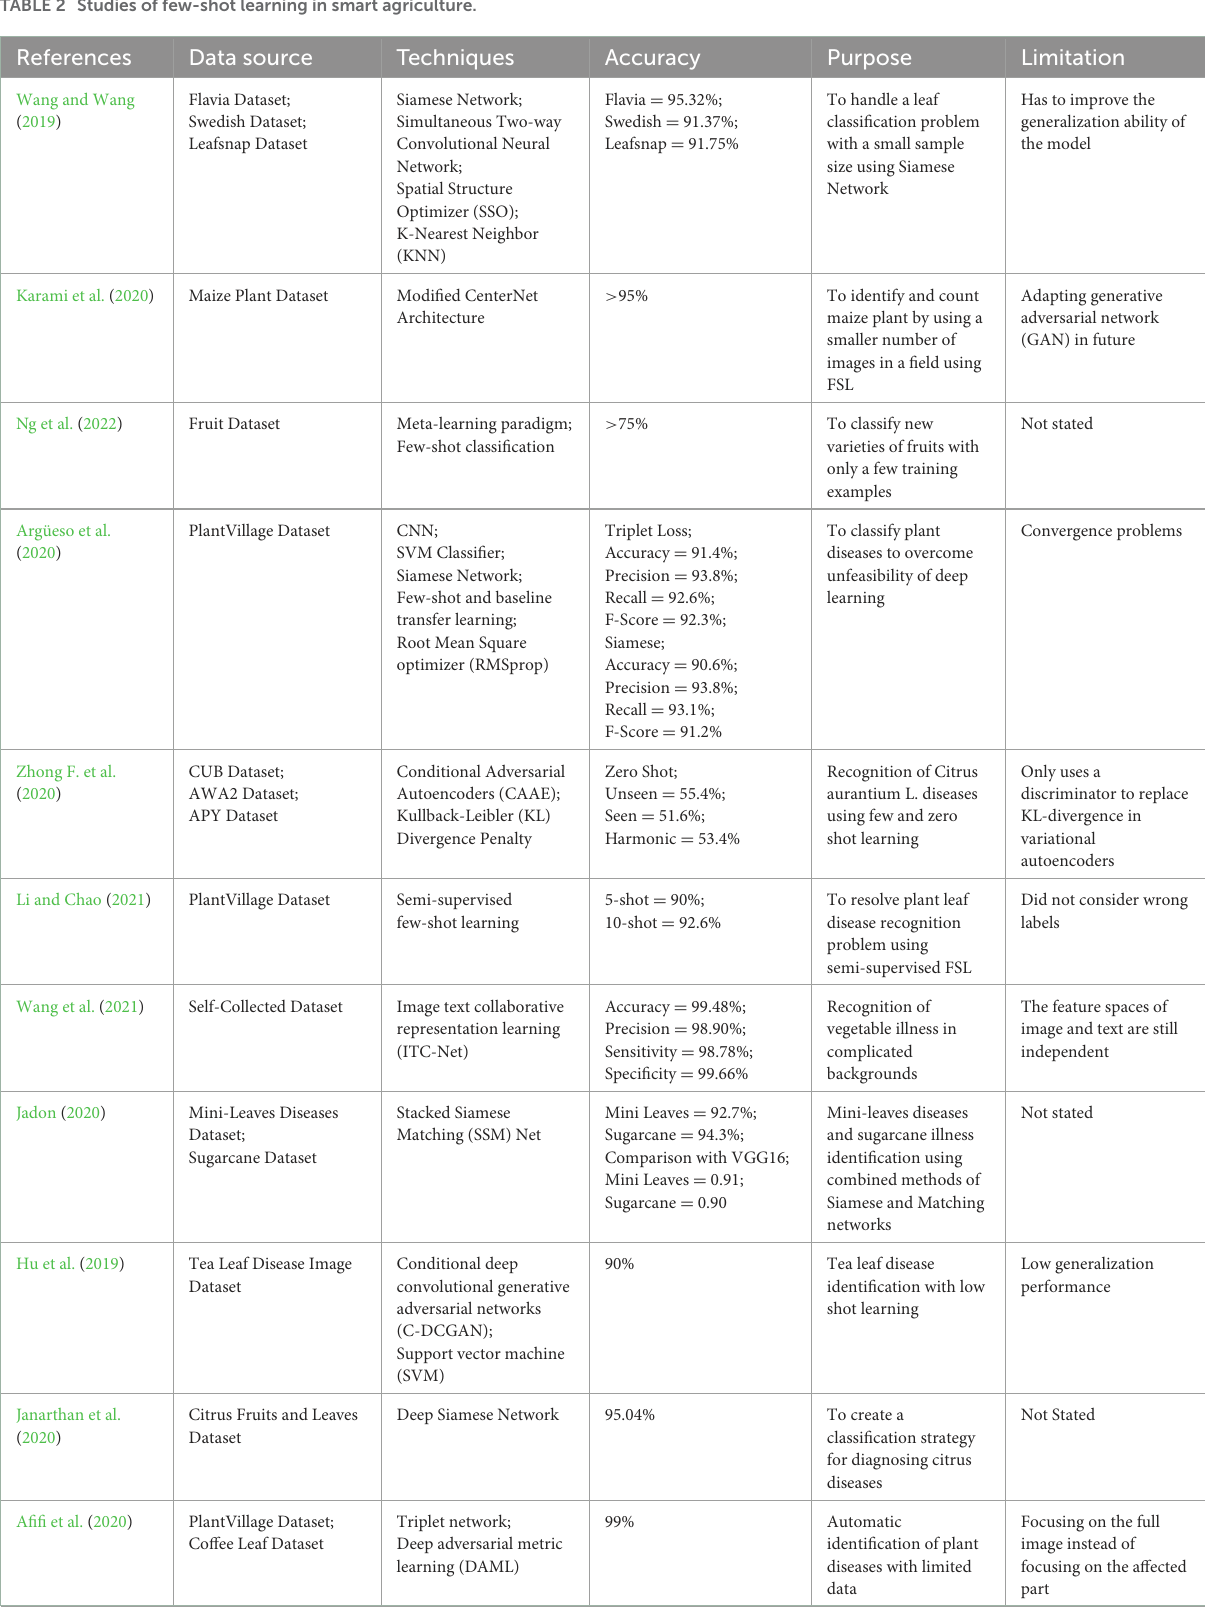
TABLE 2 Studies of few-shot learning in smart